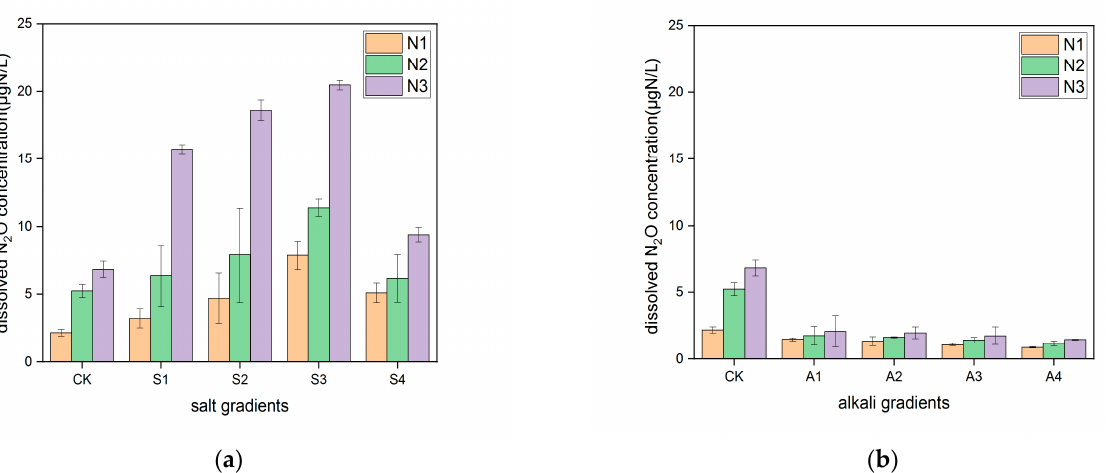
Figure 2. Dissolved N 2 O concentration in the water treated with different salinity and alkalinity: ( a ) dissolved N 2 O concentration in the water treated with different salinity ( n = 45); ( b ) dissolved N 2 O concentration in the water treated with different alkalinity ( n = 45).